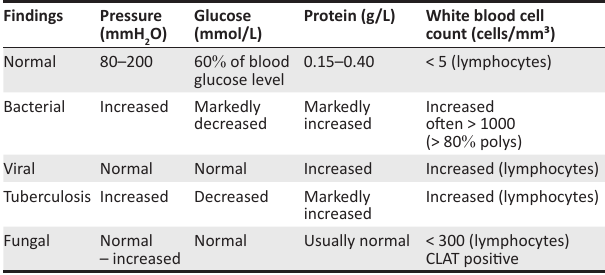
TABLE 1: Interpretation of cerebrospinal fluid findings in meningitis. Findings